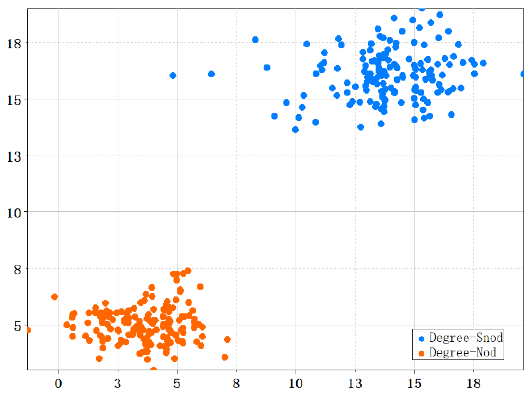
Figure 6. Magnitude of pitch variation in different cases.